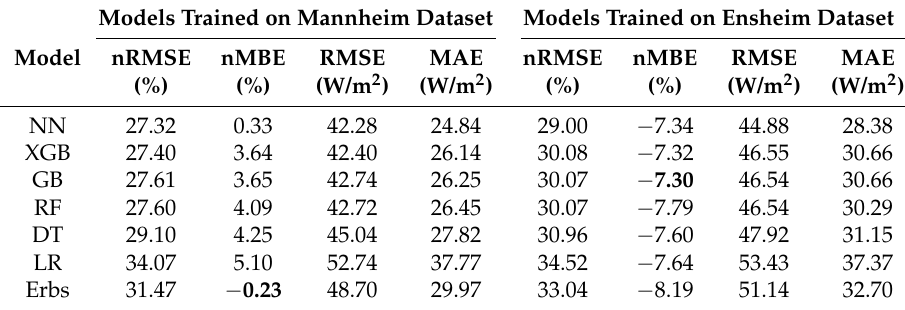
Table 9. The performance metrics of different models trained on Mannheim and Ensheim climates. The results show the error in the prediction of diffuse horizontal irradiance (2017 data) on Weinbiet climate (unseen